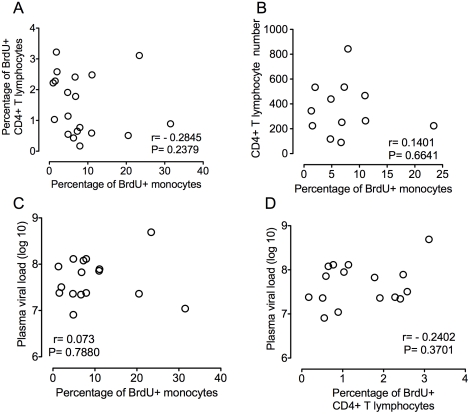
Percentage of BrdU+ monocytes does not correlate with plasma virus or CD4+ T lymphocyte turnover or numbers.
A. Paired XY values for percentage of BrdU incorporation in CD4+ T lymphocytes and monocytes in all infected animals are plotted. No correlation is found between the percentage of BrdU+ monocytes and the percentage of BrdU+ CD4+ T lymphocytes (P = 0.2379). B. Paired XY values for percentage of BrdU incorporation monocytes and CD4+ T lymphocyte counts in all seven infected animals are plotted. No correlation is found between the percentage of BrdU+ monocytes and CD4+ T cell counts (P = 6641). C. Paired XY values for percentage of monocyte BrdU incorporation and plasma viral load in all infected animals are plotted. No correlation is found between the percentage of BrdU+ monocytes and plasma viral loads P = 7880. D. Paired XY values for percentage of BrdU+ CD4+ T cells and plasma virus in all infected animals are plotted. No correlation is found between the percentage of BrdU+ CD4+ T cells and plasma viral loads P = 0.3701. A Spearman rank test is used for statistics.